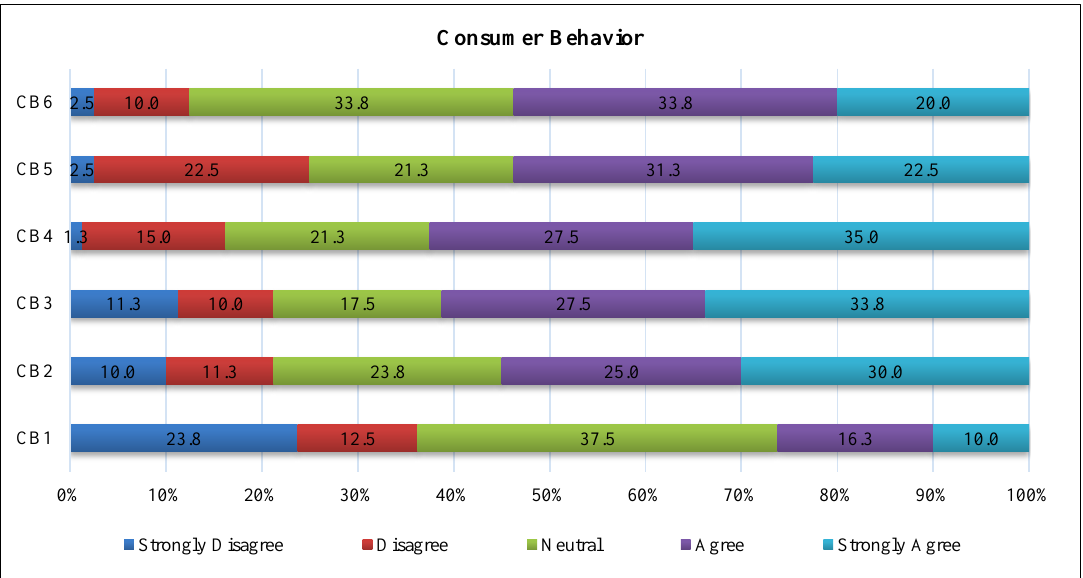
Figure 5. Level of agreement for Consumer Behavior